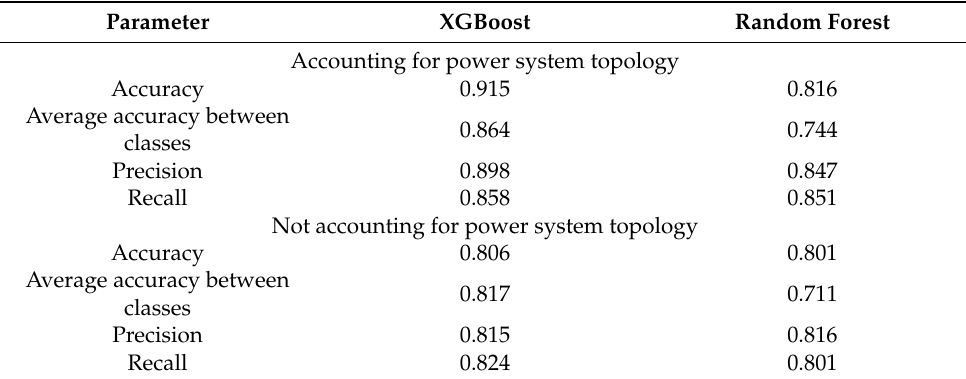
Table 3. Comparison of results of testing the trained